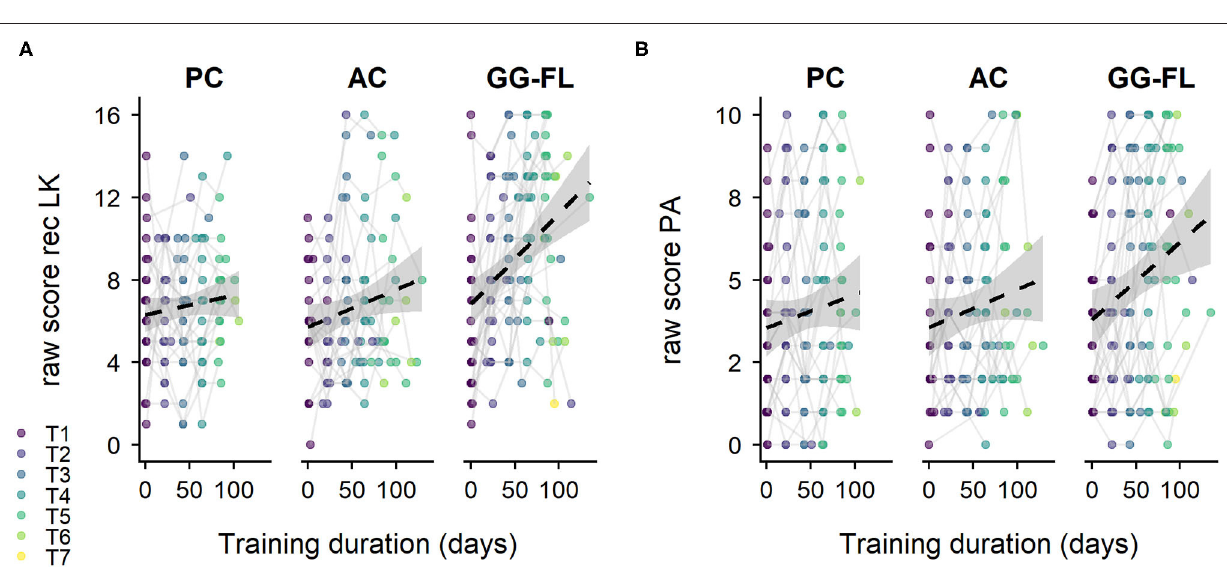
FIGURE 5 | Specifically trained decoding-related skills—intermediate assessments. (A) , Raw receptive letter knowledge scores. (B) , Raw phonological awareness scores. rec LK, receptive letter knowledge; PA, phonological awareness; PC, passive control group; AC, active control group; GG-FL, GraphoGame Flemish group; T1-T7, trial 1–trial 7. The dashed lines represent the estimated linear